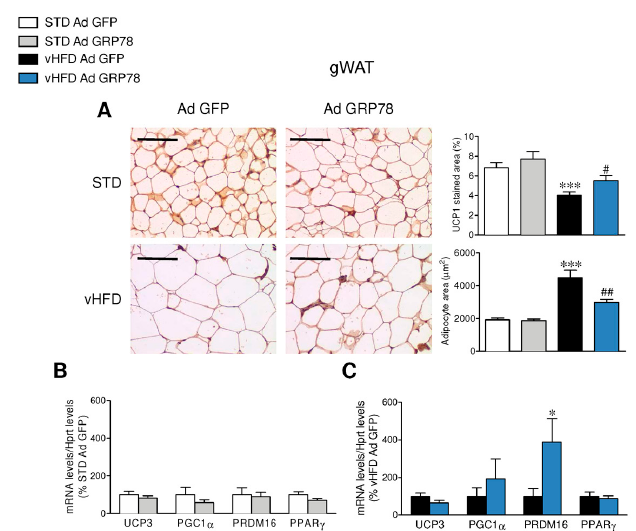
Figure 3. Effect of GRP78 overexpression in the VMH of vHFD rats on gonadal white adipose tissue (gWAT) browning. ( A ) Representative immunohistochemistry with anti-UCP1 antibody showing UCP1 staining (left panels; original magnification 20×; scale bar 100 µm), UCP1 stained area (right upper panels; n = 8–10 animals per group), adipocyte area (right lower panels; n = 8–10 animals per group) and ( B , C ) relative messenger RNA (mRNA) levels of thermogenic markers ( n = 8–10 animals per group) in the gWAT of the STD or vHFD rats stereotaxically treated with GFP or GRP78 adenoviruses into the VMH. Statistical significance was determined by t -Student test or ANOVA. Error bars represent the SEM. * p < 0.05 and *** p < 0.001 vs. (STD or vHFD) Ad GFP; # p < 0.05 and ## p < 0.01 vs. vHFD Ad GFP (panel A ).